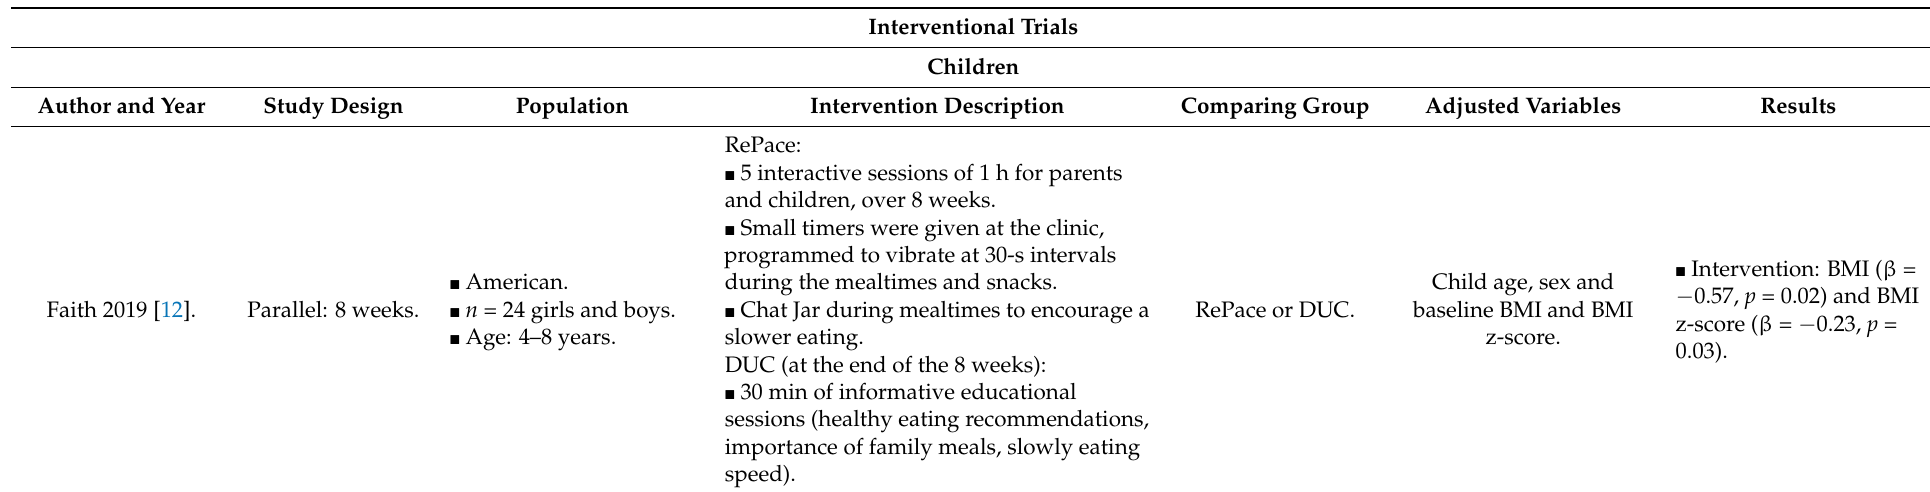
Table 5. Characteristics and main findings of interventional trials that explored eating